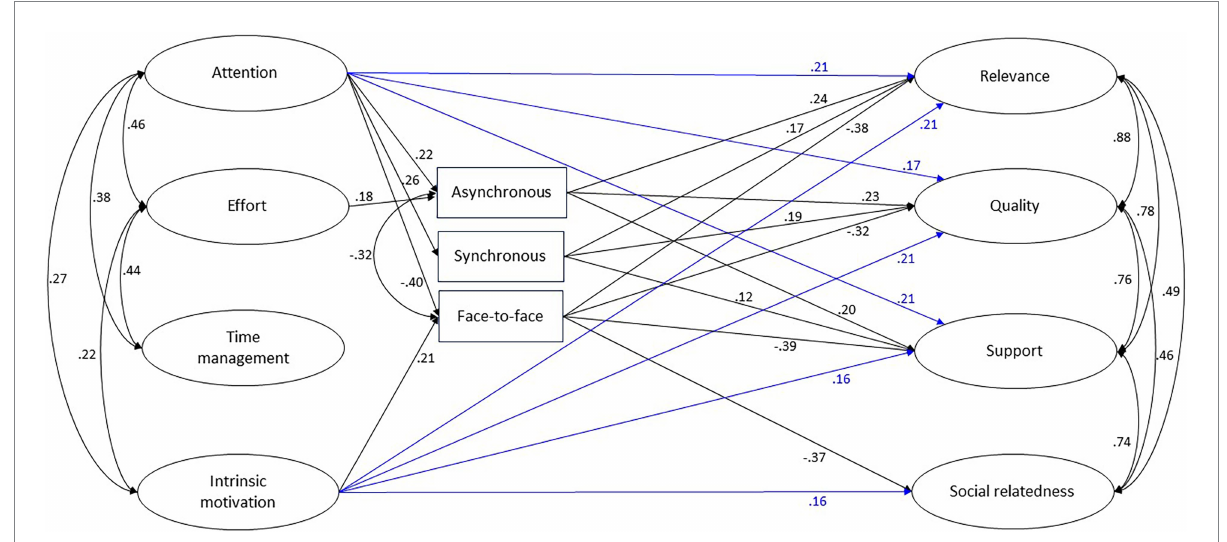
FIGURE 2 Structural equation model. Only paths p < 0.05 are displayed. See Table 3 for direct and indirect effects among variables. Blue = direct